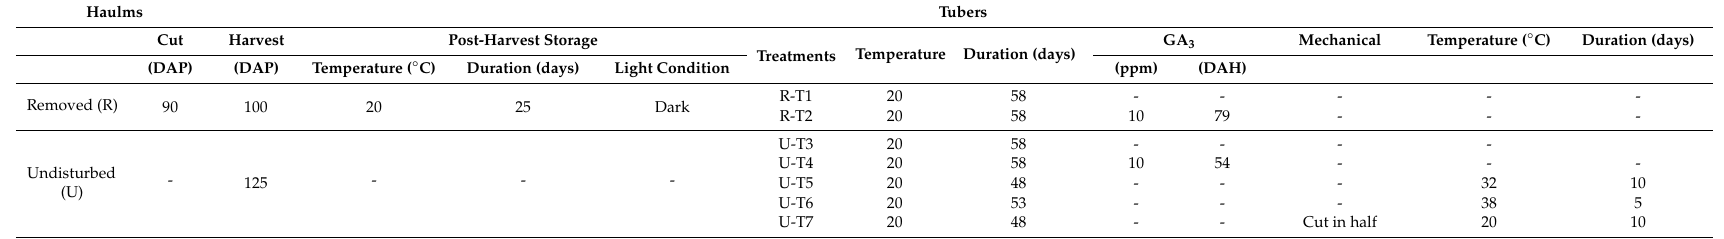
Table 2. Experiment 2 (2000). DAP: days after planting; GA 3 : gibberellic acid application; DAH: days after harvesting.